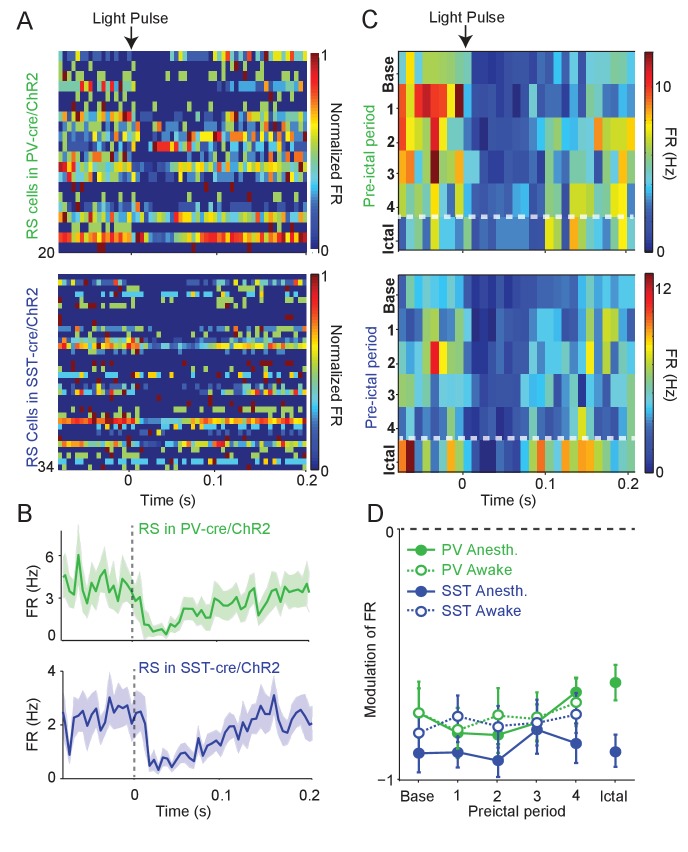
Intact preictal suppression of RS firing by evoked inhibition.(A) Normalized firing rate (FR) as a function of time (s) from laser pulse onset (t = 0) for RS cells recorded simultaneously with PV cells in PV-Cre/ChR2 mice (n = 20 cells in 12 mice) or recorded with SST cells in SST-Cre/ChR2 mice (n = 34 cells in 16 mice) during baseline activity. For purposes of visualization, firing rates were normalized to the maximum firing rate for each cell. (B) Mean changes in baseline firing rate (Hz) of RS cells as a function of time (s) from laser pulse onset (dashed grey line). (C) Upper: Average firing rate of RS cells (n = 11 cells in eight mice) recorded during PV/ChR2 experiments as a function of time (s) from laser pulse onset during baseline, the four preictal periods and a 60 s period following ictal onset after PTZ administration (see Materials and methods). Lower: Average firing rate of RS cells (n = 11 cells in seven mice) recorded during SST/ChR2 experiments as a function of time (s) from laser pulse onset during baseline, the four preictal periods and following ictal onset. For these plots, we considered only light pulses of high light intensity (see Materials and methods). (D). Mean modulation of firing rate (see Materials and methods) after high-intensity laser pulse (0 to 50 ms) compared to pre-pulse (−200 to 0 ms) firing rate for RS cells recorded during PV/ChR2 (green) and SST/ChR2 (blue) experiments. Data from lightly anesthetized animals are shown as filled symbols and data from awake animals are shown as open symbols. Modulation scores for RS in PV-Cre and RS in SST-Cre were significantly different from zero for all periods. Error bars denote mean ±s.e.m.10.7554/eLife.40750.011Figure 3—source data 1.Figure 3 - Statistical results.